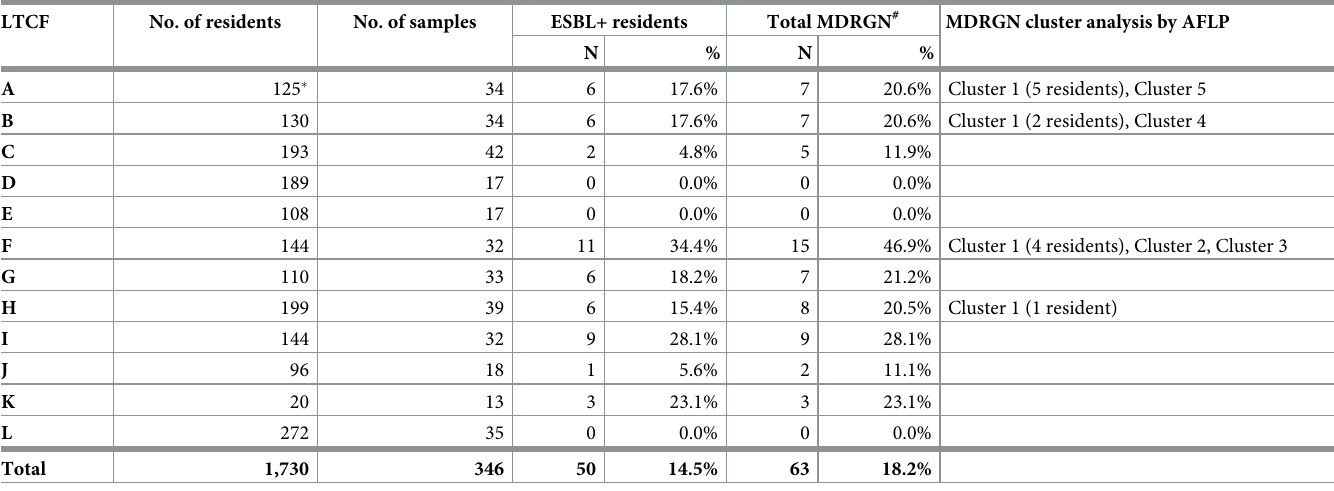
Table 1. Characteristics and MDRGN prevalence of 12 participating LTCFs.